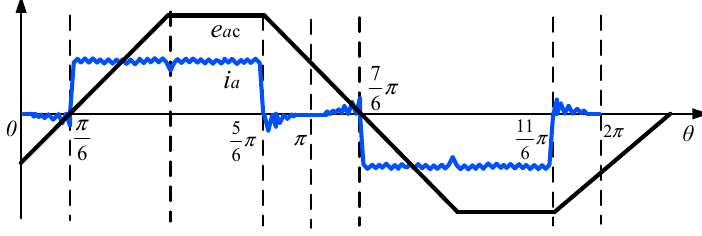
Figure 9. Six commonly used PWM-control methods. PWM: pulse-width modulation.